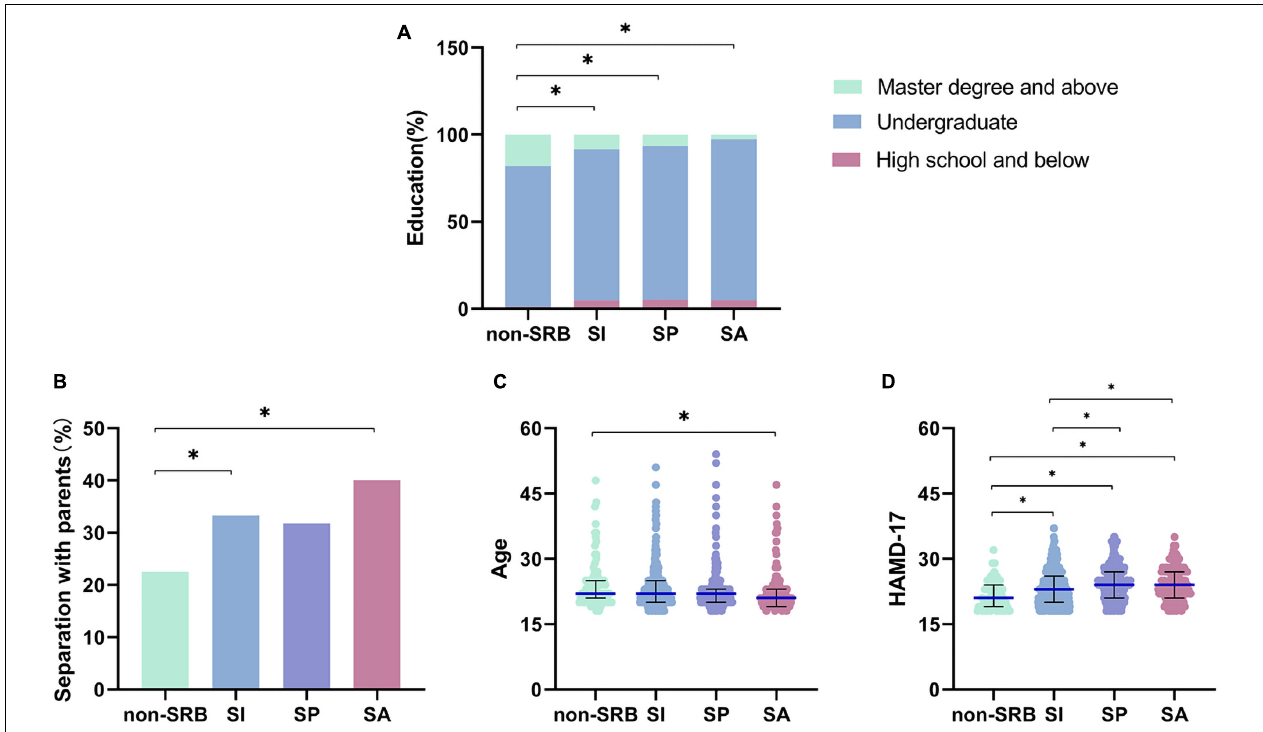
FIGURE 2 | Pairwise comparison of Socio-demographic characteristics. (A) Education level in patients. (B) Separation with parents in patients. (C) Age in patients. (D) Severity of symptoms of depression in patients. ∗ P < 0.05. Non-SRB, group without suicide-related behavior; SI, group with suicidal ideation; SP, group with suicidal plan; SA, group with suicidal